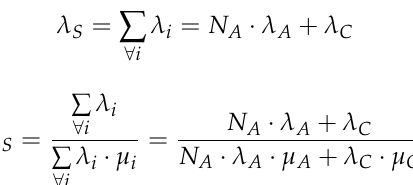
Figure 3. Configuration of photovoltaic (PV) system.